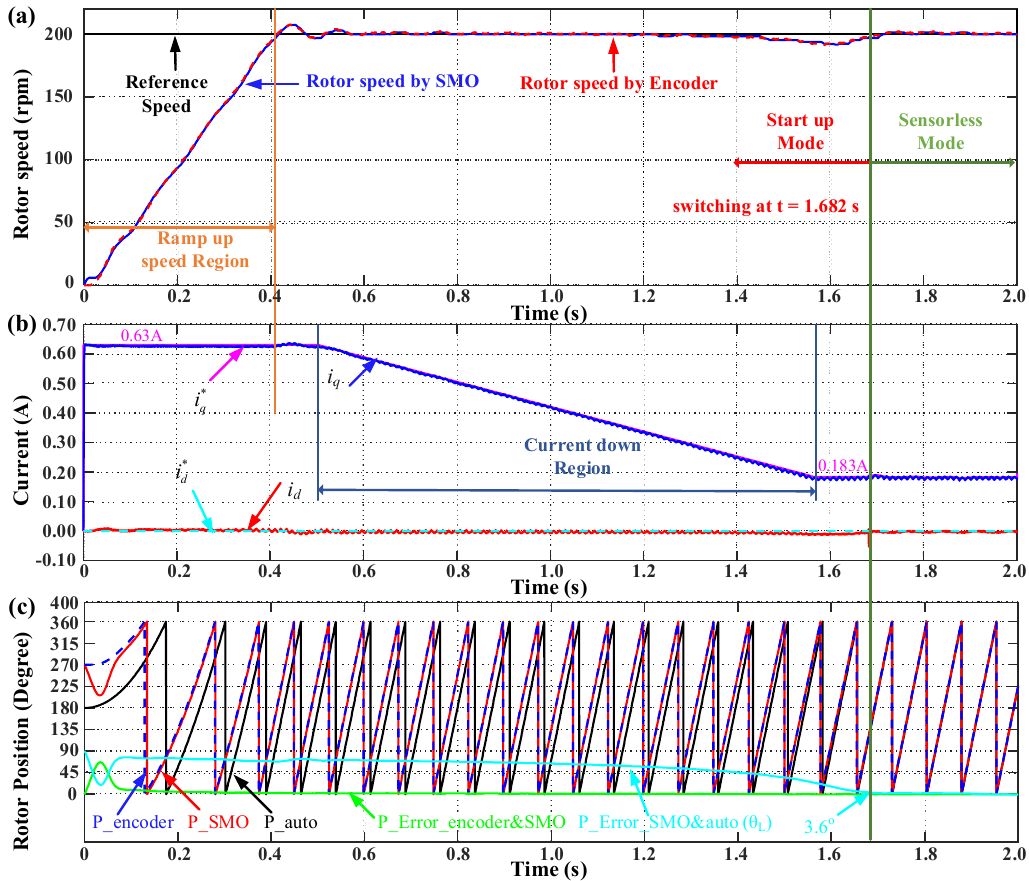
Figure 9. Simulation results in the startup mode and sensorless switching, from 0 rpm to 200 rpm for ( a ) speed response, ( b ) current response, ( c ) rotor position response.